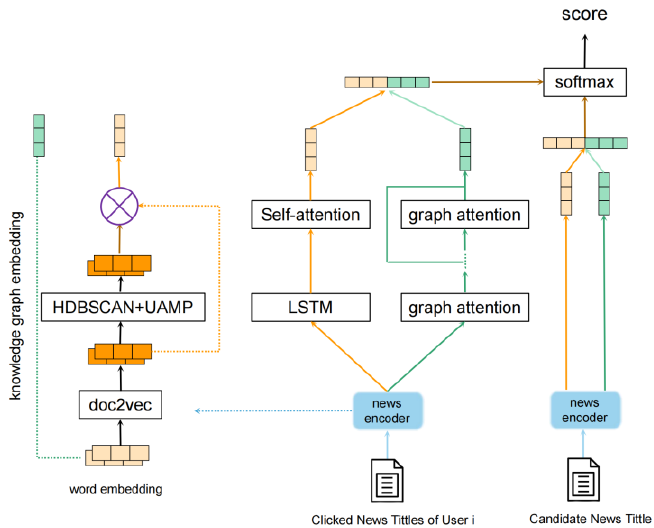
Figure 2. The framework of our NRTEH approach.